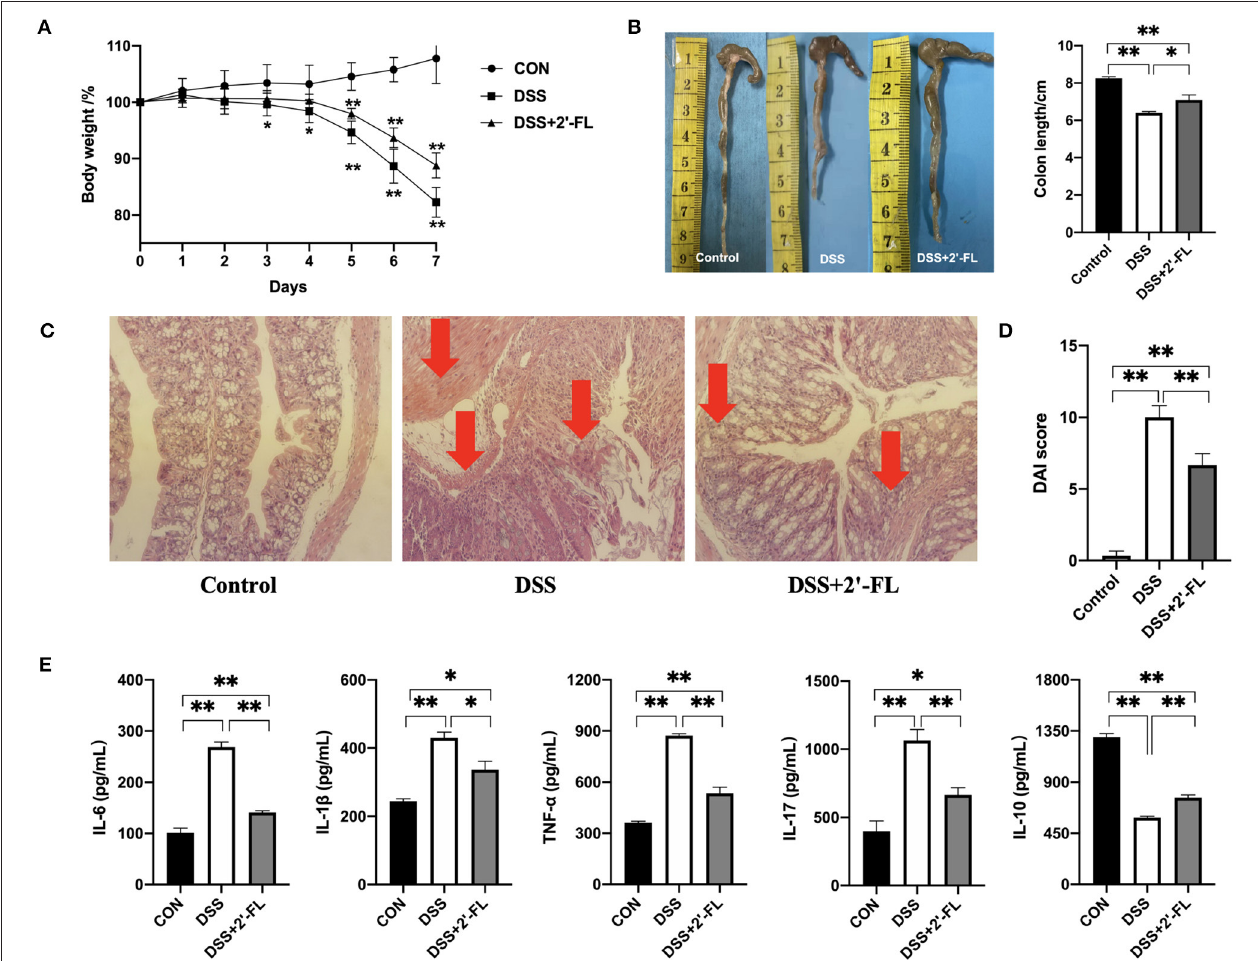
FIGURE 3 | 2 ′ -FL remits dextran sulfate sodium (DSS)-induced colon inflammation in C57BL/6J mice. (A) Changes in the body weight of mice after receiving 5% DSS water; (B) The representative images (left) and statistical analyses (right) of colon length; (C) Representative images of colon by H&E staining (100X); (D) Disease activity index (DAI) indices; (E) Cytokine levels in serum of C57BL/6J mice detected by ELISA. Significance was determined using one-way ANOVA analysis and expressed as mean ± SEM. * p < 0.05; ** p <